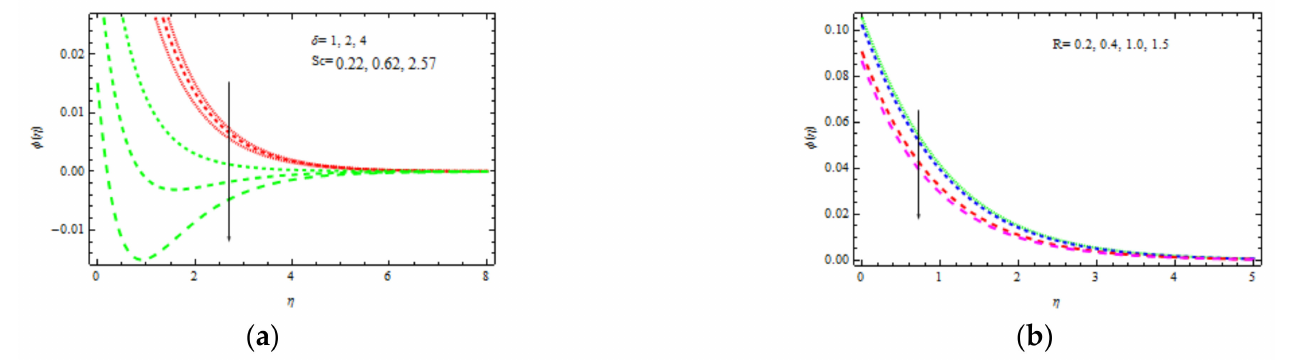
Figure 11. Inspiration of δ , Sc ( a ) and R ( b ) on concentration.